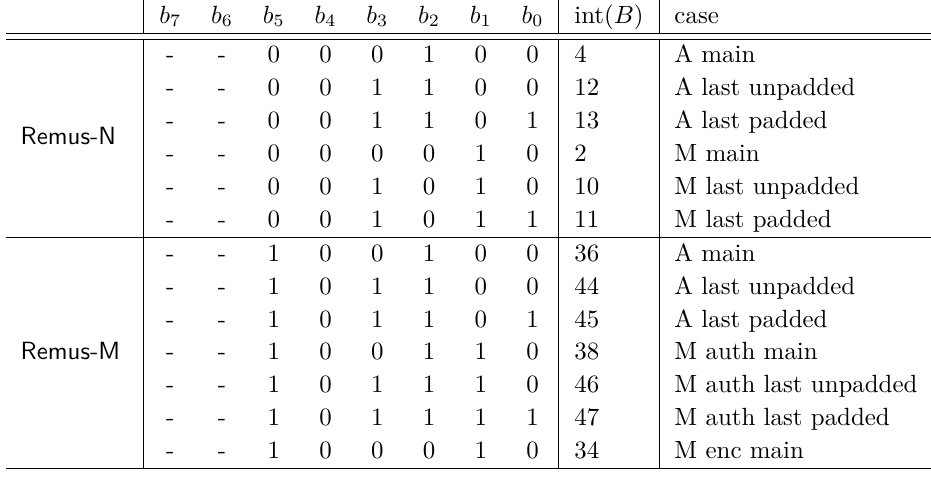
Table 8: Domain separation byte B of Remus . Bits b 7 and b 6 are to be set to the appropriate value according to the parameter